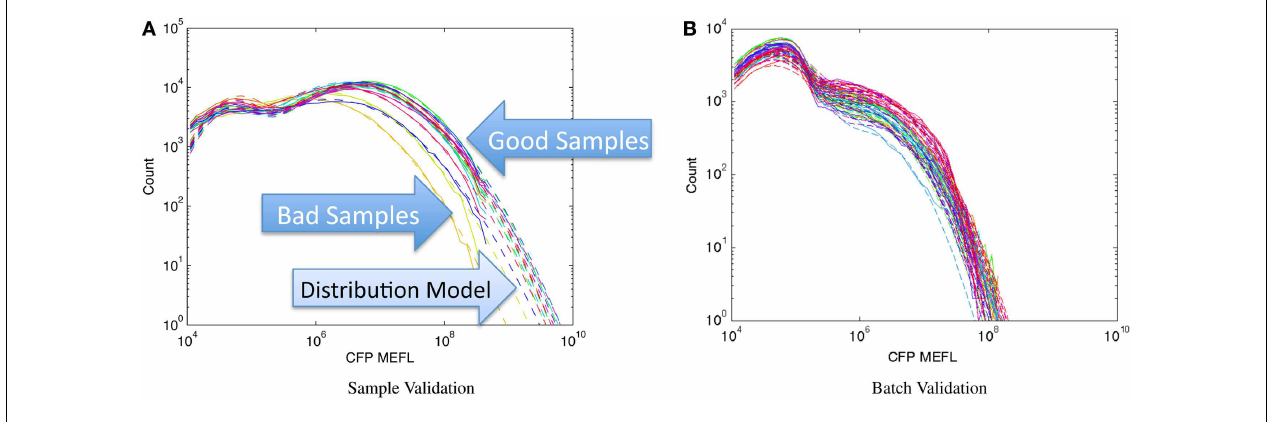
sample material on Adler et al. (2014): solid lines are observed distribution, dashed lines are bimodal model fit, used for quantitative comparison of sample to expected